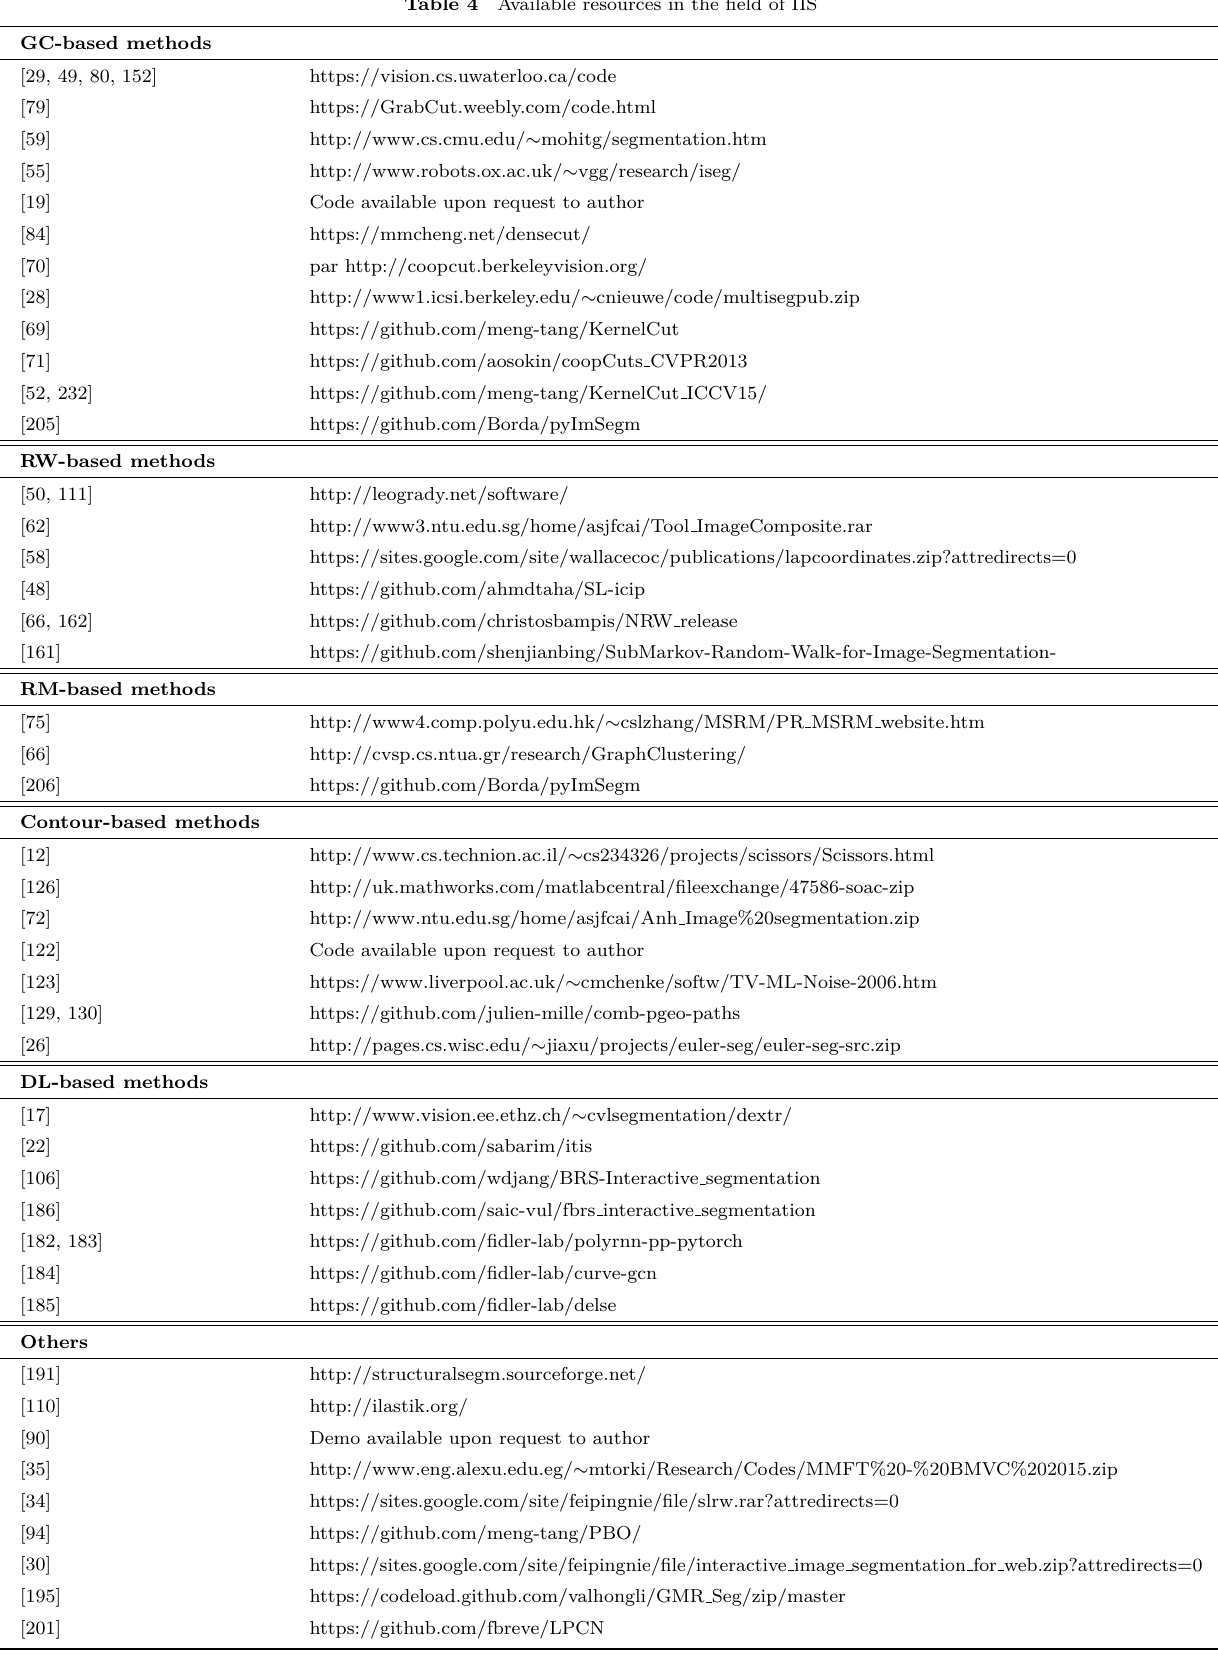
Table 4 Available resources in the field of